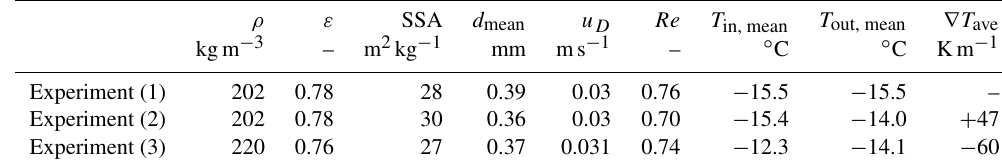
Table 1. Morphological properties and flow characteristics of the experimental runs: µCT measured snow density ( ρ ), porosity ( ε ), specific surface area per unit mass (SSA), mean pore space diameter ( d mean ), superficial velocity in snow ( u D ), corresponding Reynolds num- ber ( Re = d mean · u D /ν air ), average inlet temperature of the humidifier and at the inlet ( T in, mean ), average outlet temperature at the outlet ( T out, mean ) and average temperature gradient ( ∇ T ave ). Experiment (1) corresponds to the isothermal conditions, experiment (2) to air warm- ing and experiment (3) to air cooling in the snow sample.